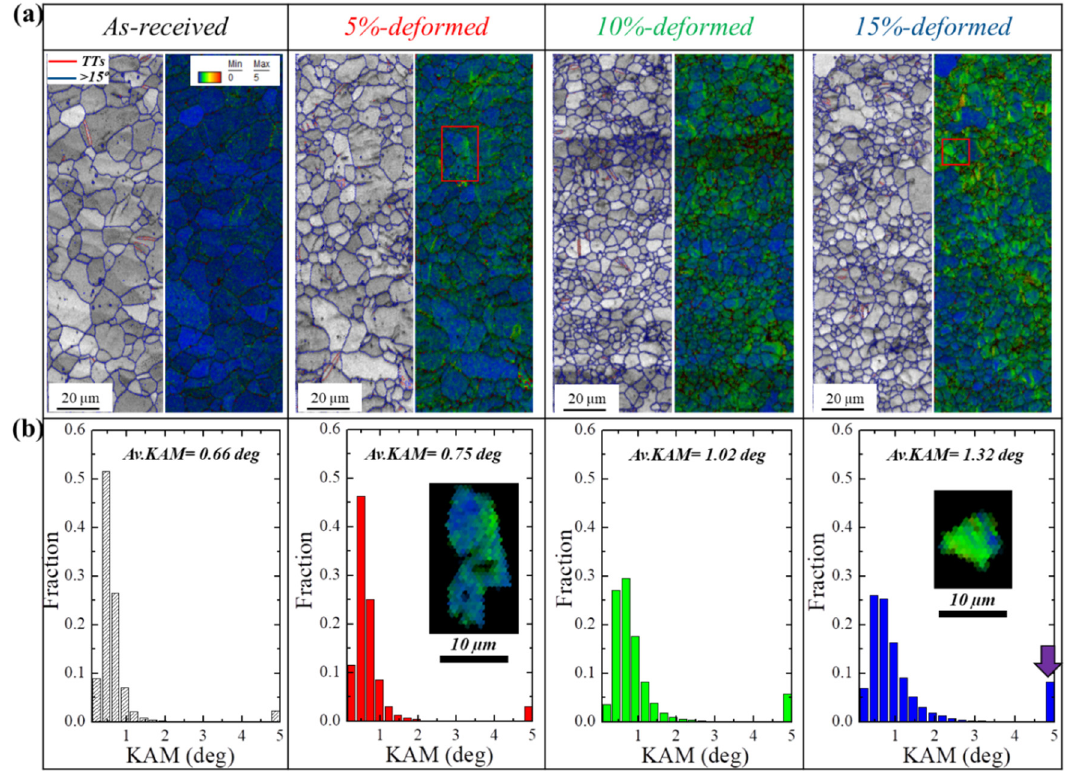
Figure 3. ( a ) Image quality with tension twins and kernel average misorientation and ( b ) kernel average misorientation profile of the of the as-received and stretched (5%, 10% and 15%) samples. The figures inserted in Figure b show separated grains taken from indicated areas in Figure 3a.